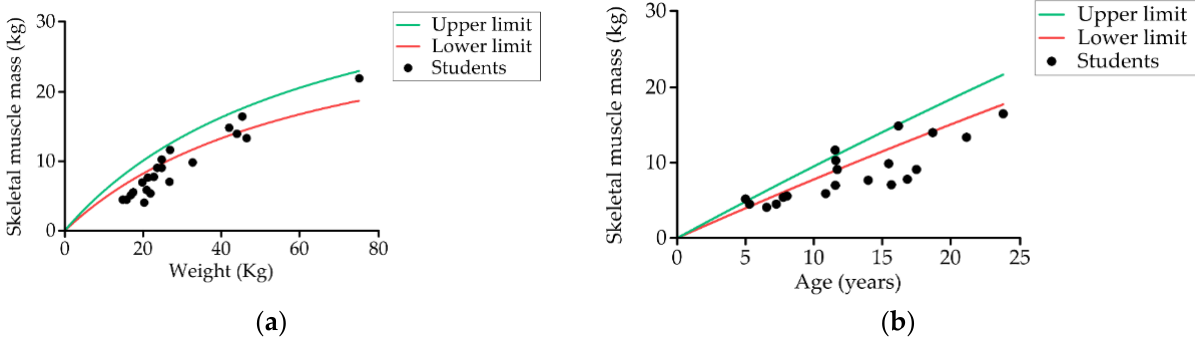
Figure 4. Relationship between students’ ( a ) skeletal muscle mass and weight, and ( b ) skeletal muscle mass and age compared to individual reference parameters obtained by bioelectrical impedance analysis ( n = 20).